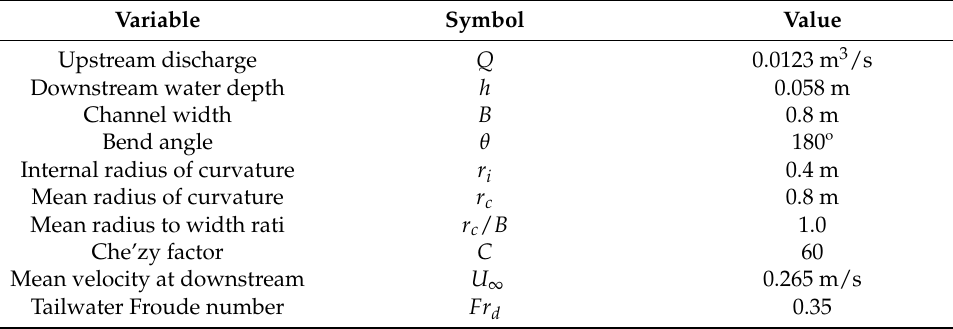
Figure 5. The refined mesh . 3.2. Results of Curved Channel 3.2.1. Velocity Distribution The velocity distribution of the curved open channel is shown in Figures 6 and 7 for the two numerical models. It appeared that the maximum velocity moved from the